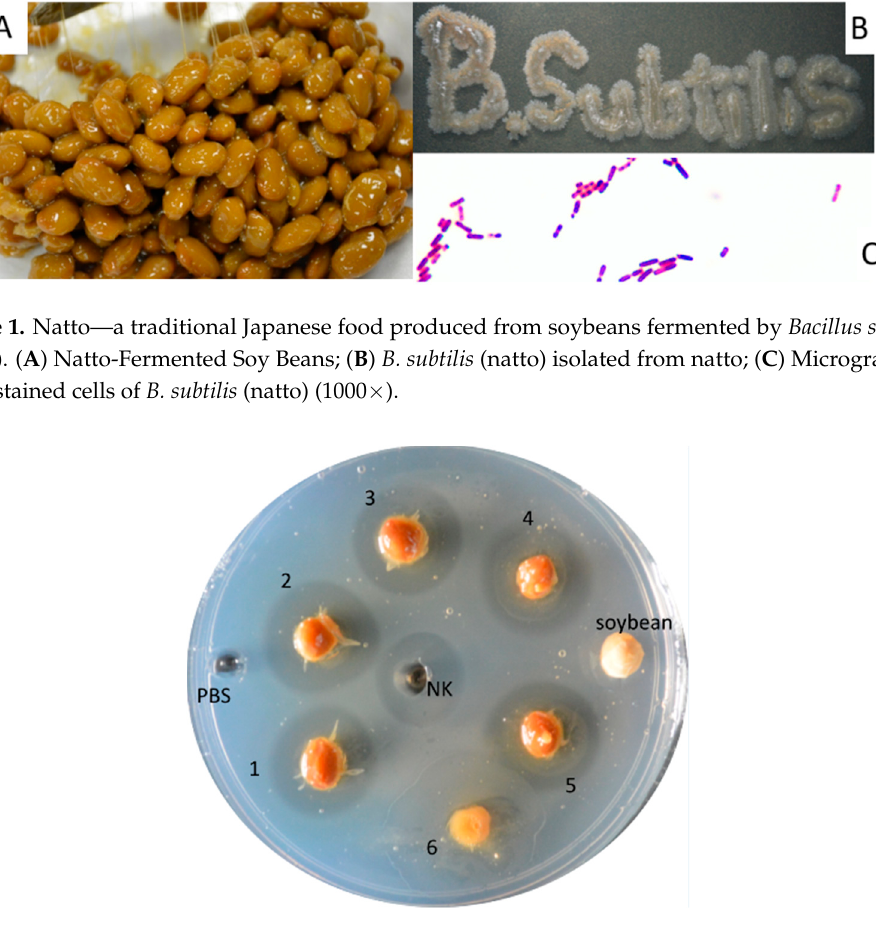
Figure 2. Natto and nattokinase can dissolve fibrin (semi-transparent halo ring). (1–5) Natto-fermented soy beans; (6) Slimy material characteristic of natto; (NK) Commercial nattokinase (100 µg) as a positive control; Non-fermented soybean and PBS (phosphate buffered saline) as negative controls.